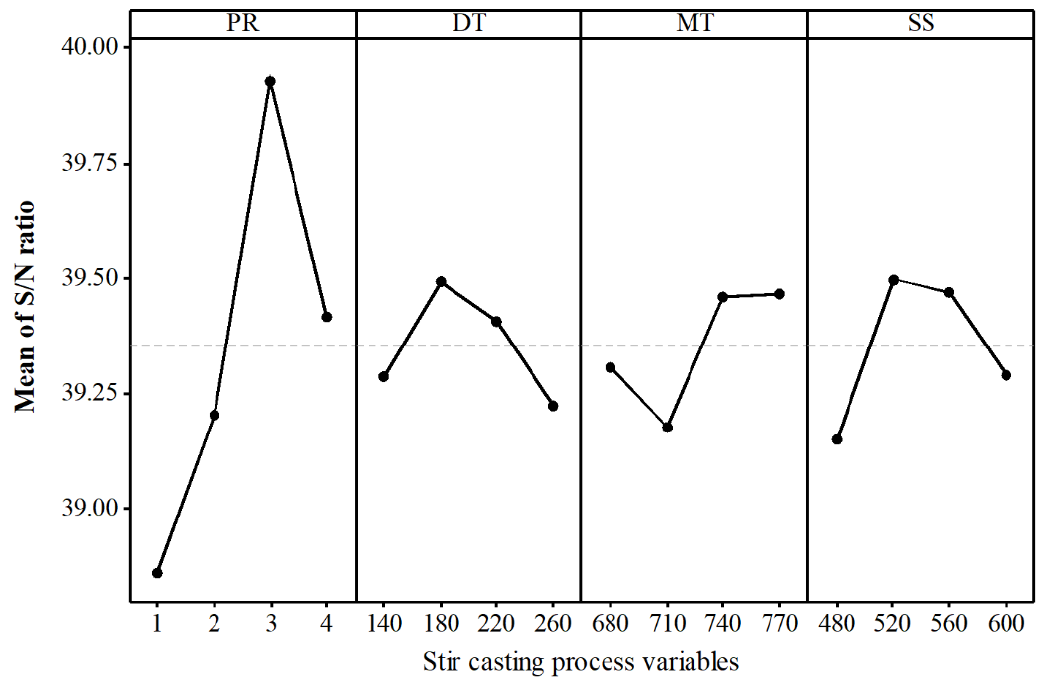
Figure 6. Main effect plots of hardness of stir casting composites.